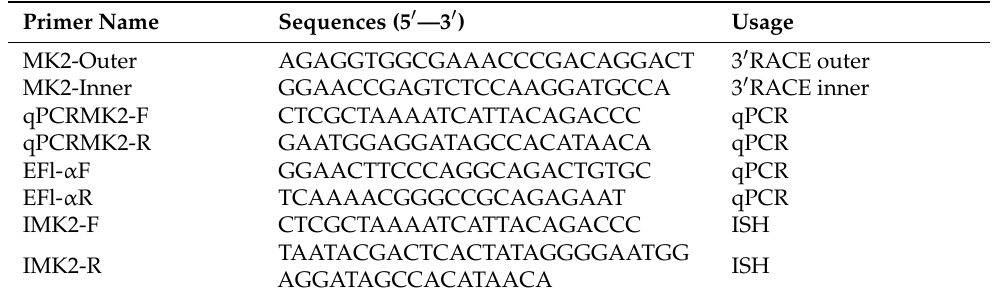
Table 1. Primers used in this